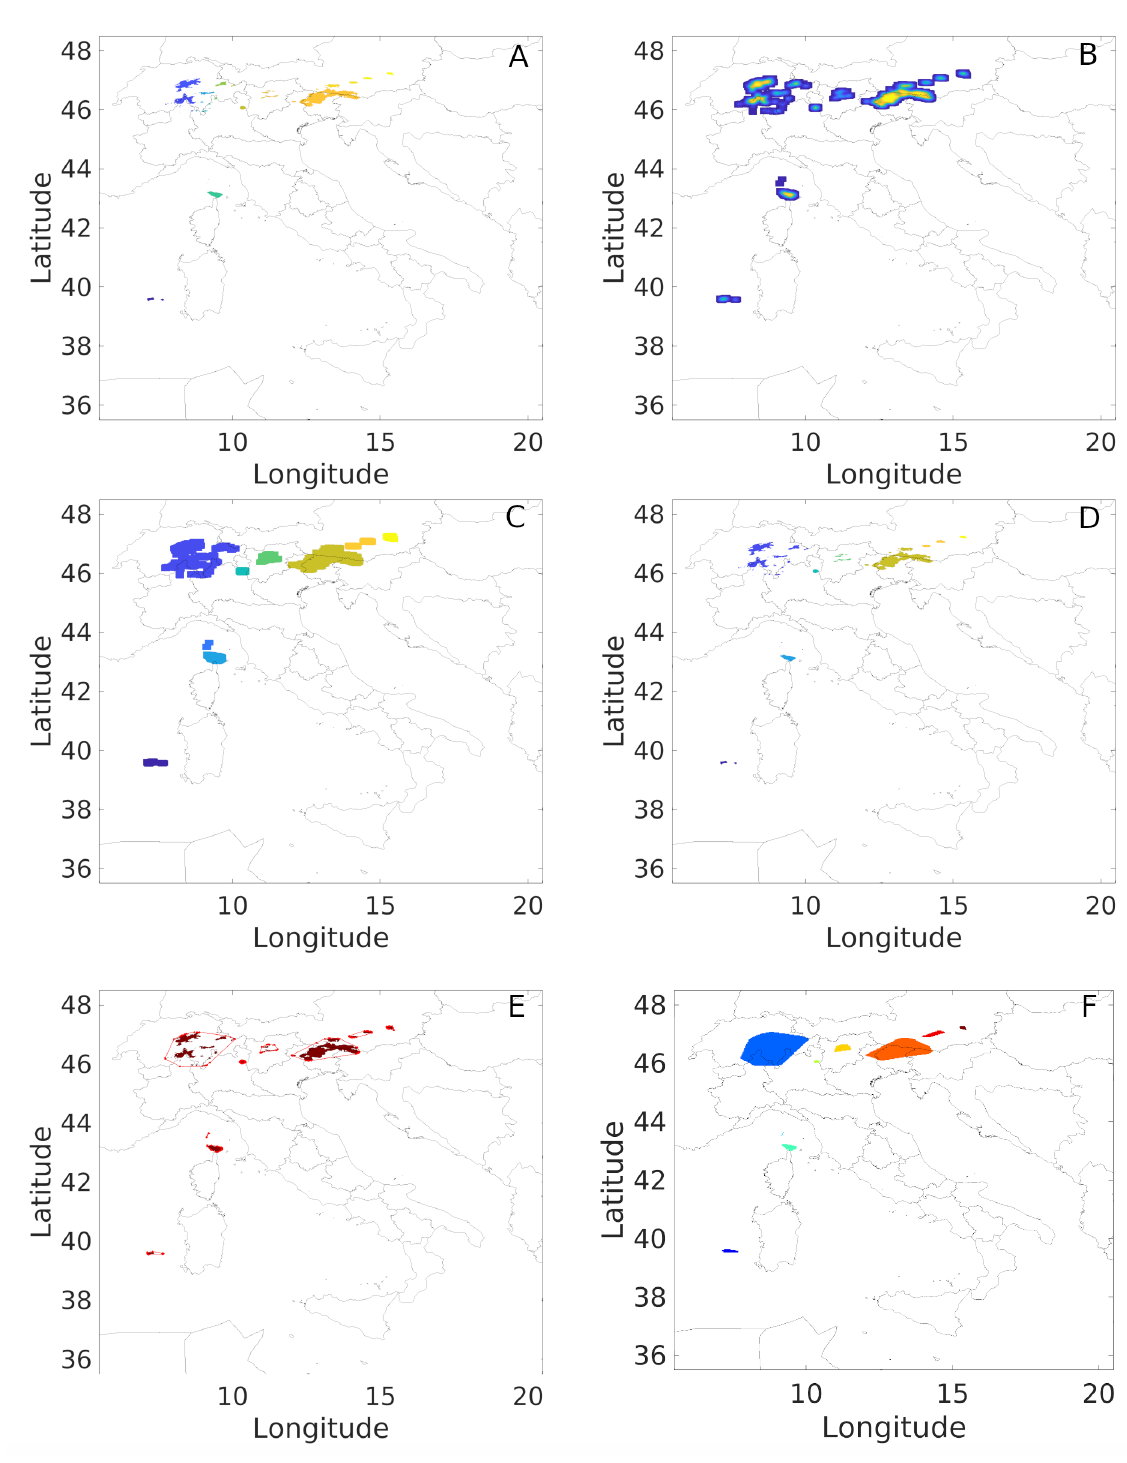
Figure 4. SWING procedure on observed objects: Panel ( A ) observed objects, Panel ( B ) Gaussian filter with sigma = 5, Panel ( C ) Merged observed object, Panel ( D ) observed object grouped together, Panel ( E ) convex hulls around grouped objects, Panel ( F ) map of merged